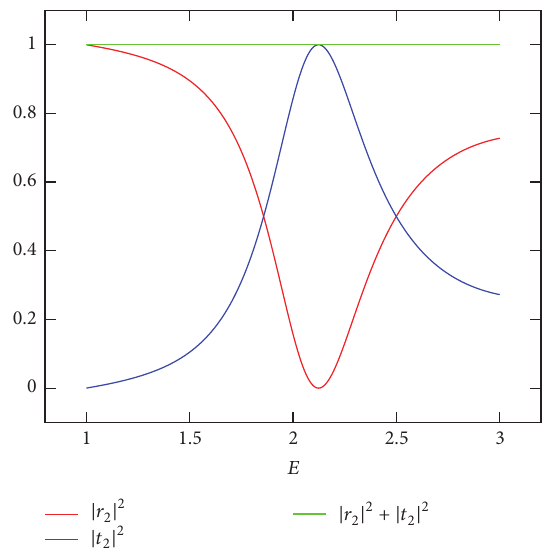
Figure 3: Plots of |𝑟 2 | 2 , |𝑡 2 | 2 , and |𝑟 2 | 2 + |𝑡 2 | 2 as energy